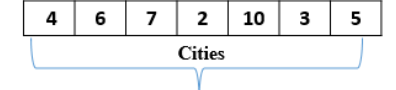
Fig. 3. An example solution of TTSP with 8 out of 10 cities